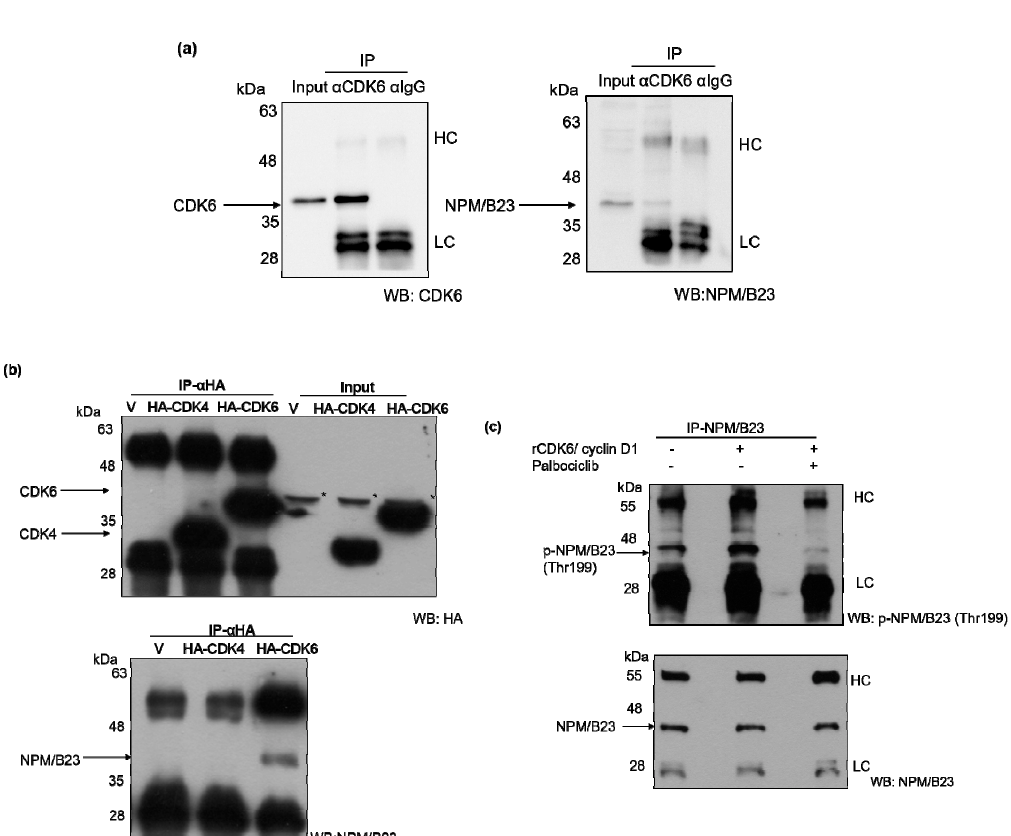
Figure 5. CDK6-mediated NPM/B23 hyperphosphorylation. ( a ) ARK2 whole-cell lysates were immunoprecipitated (IP) with an anti-CDK6 antibody ( α -CDK6) and subsequently analyzed by immunoblotting with an anti-CDK6 antibody or an anti-NPM/B23 antibody. A control IgG antibody ( α -IgG) was used for mock immunoprecipitation. ( b ) ARK2 cells were transiently transfected with